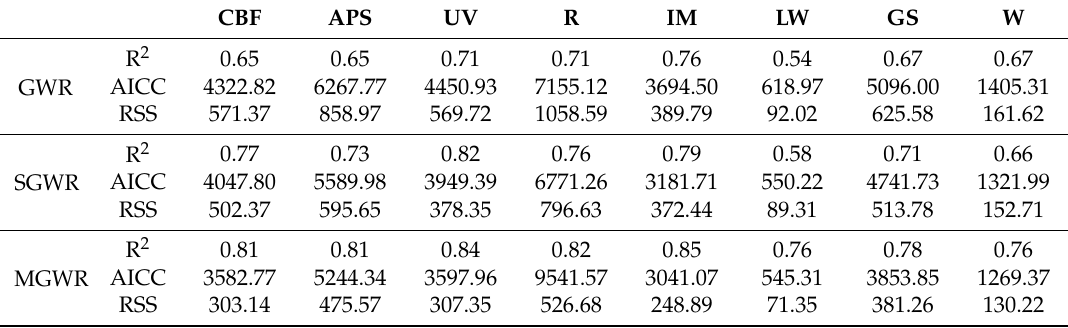
Table 5. An evaluation summary of the performance of ordinary least squares (GWR), geographically weighted regression (SGWR), and multi-scale geographically weighted regression